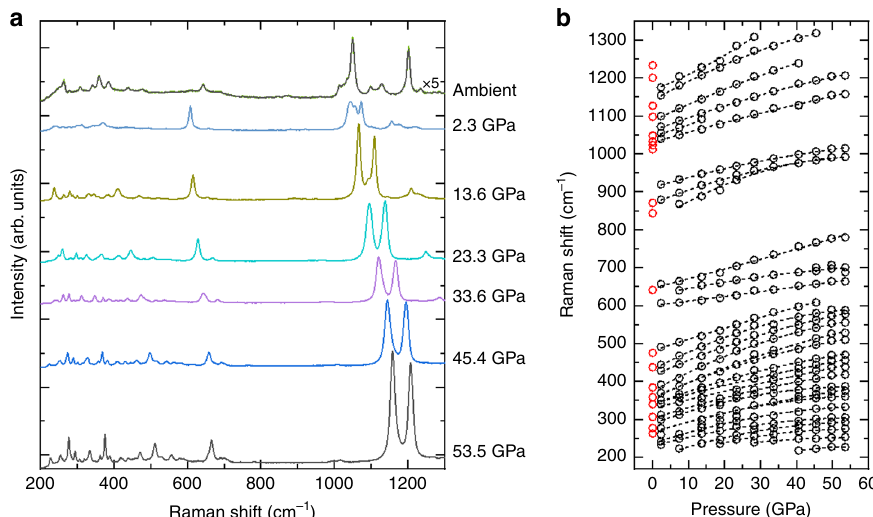
Fig. 2 Evolution of the Raman modes of the Mg 2 N 4 compounds with pressure. a Typical Raman spectra of Mg 2 N 4 taken during decompression from 53.5 GPa to ambient conditions. The spectra at ambient conditions is markedly different than those at higher pressures, evidencing a phase transition. b Pressure dependence of the Raman modes' frequencies, which evolve smoothly and continuously down to 2.3 GPa. Red dots indicate the modes at ambient pressure. The spectra are offset along the y -axis for clarity and ×5 indicates that the spectrum is fi ve-times magni fi ed